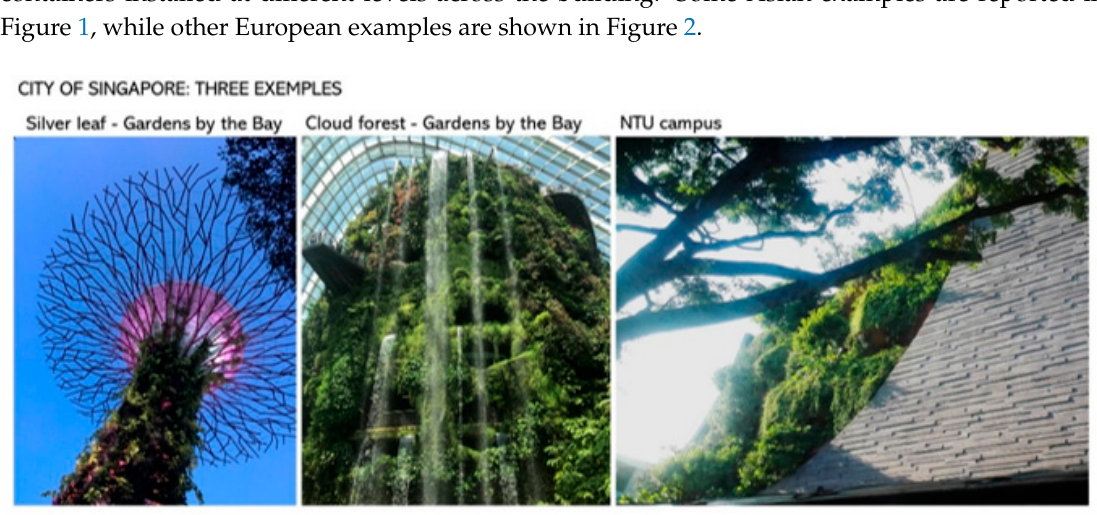
Figure 1. Three examples of green walls in the City of Singapore.